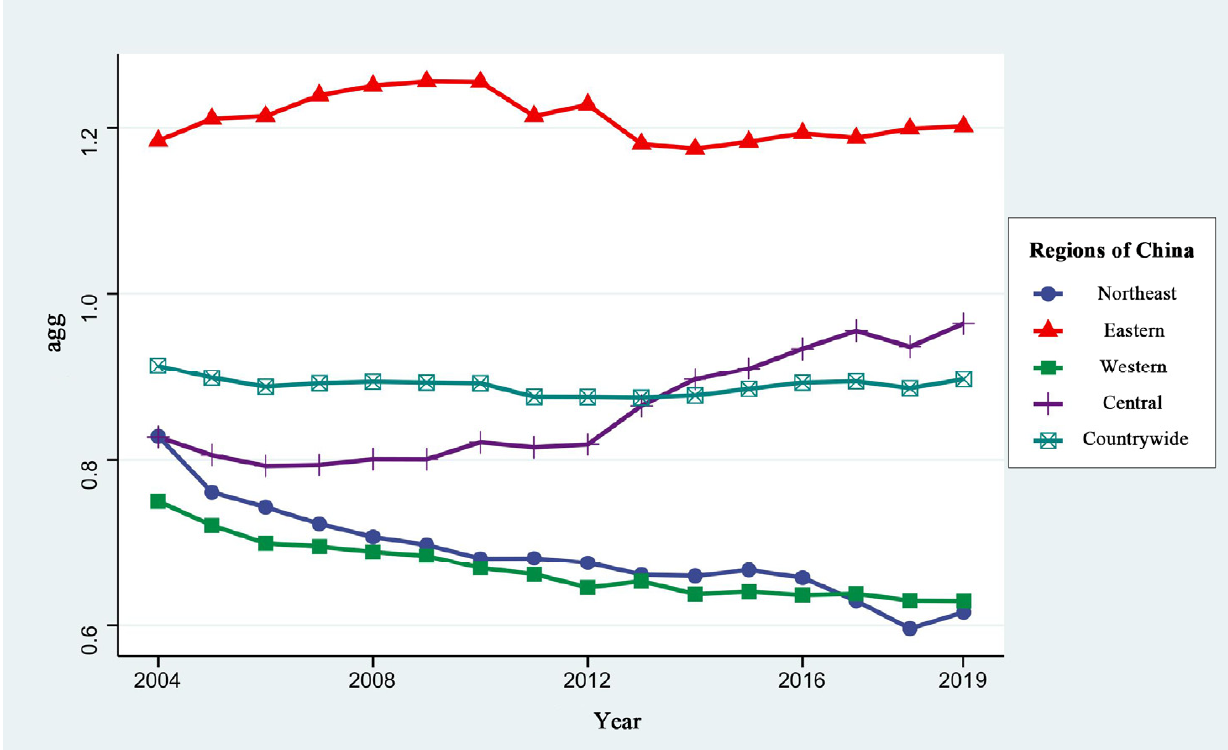
Figure 1. Changes of MA in China and its regions from 2004–2019.